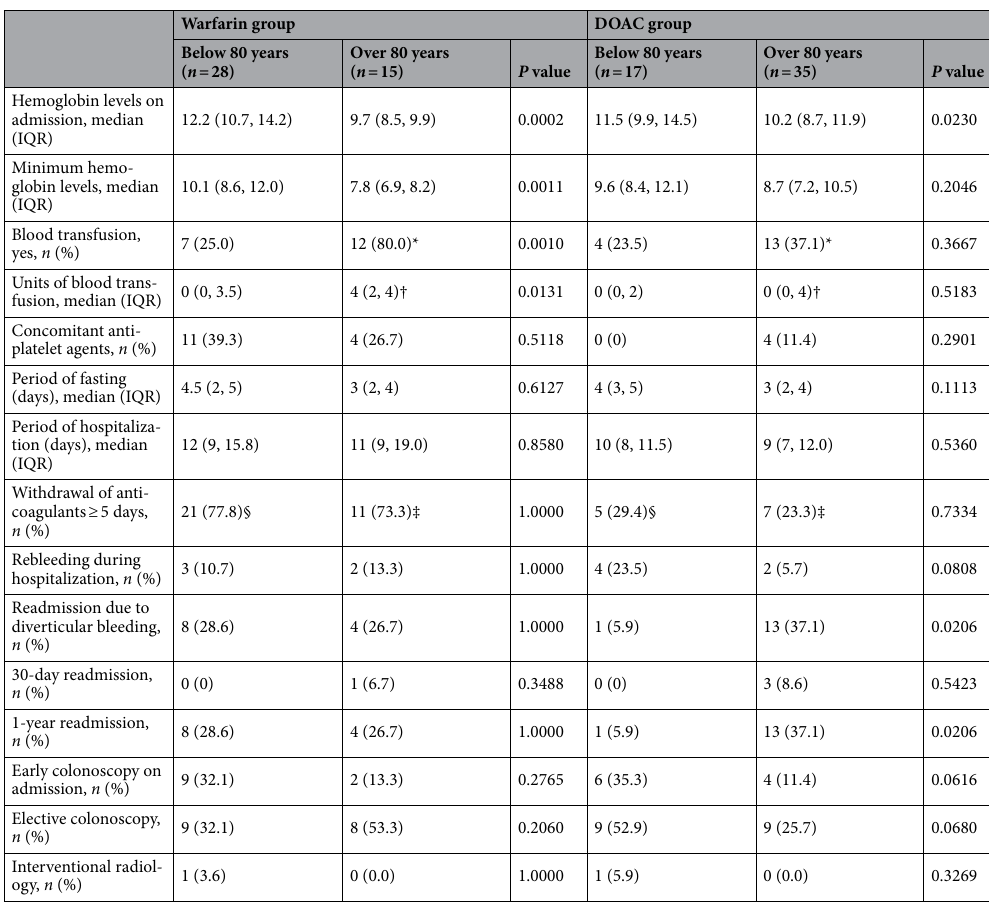
Table 4. Comparison of the patients younger than and older than 80 years of age. Comparison of warfarin and DOACs among patients aged older than 80 years, * P = 0.0121, † P = 0.0110, ‡ P = 0.0029. Comparison of warfarin and DOACs among patients aged younger than 80 years, § P = 0.0038.